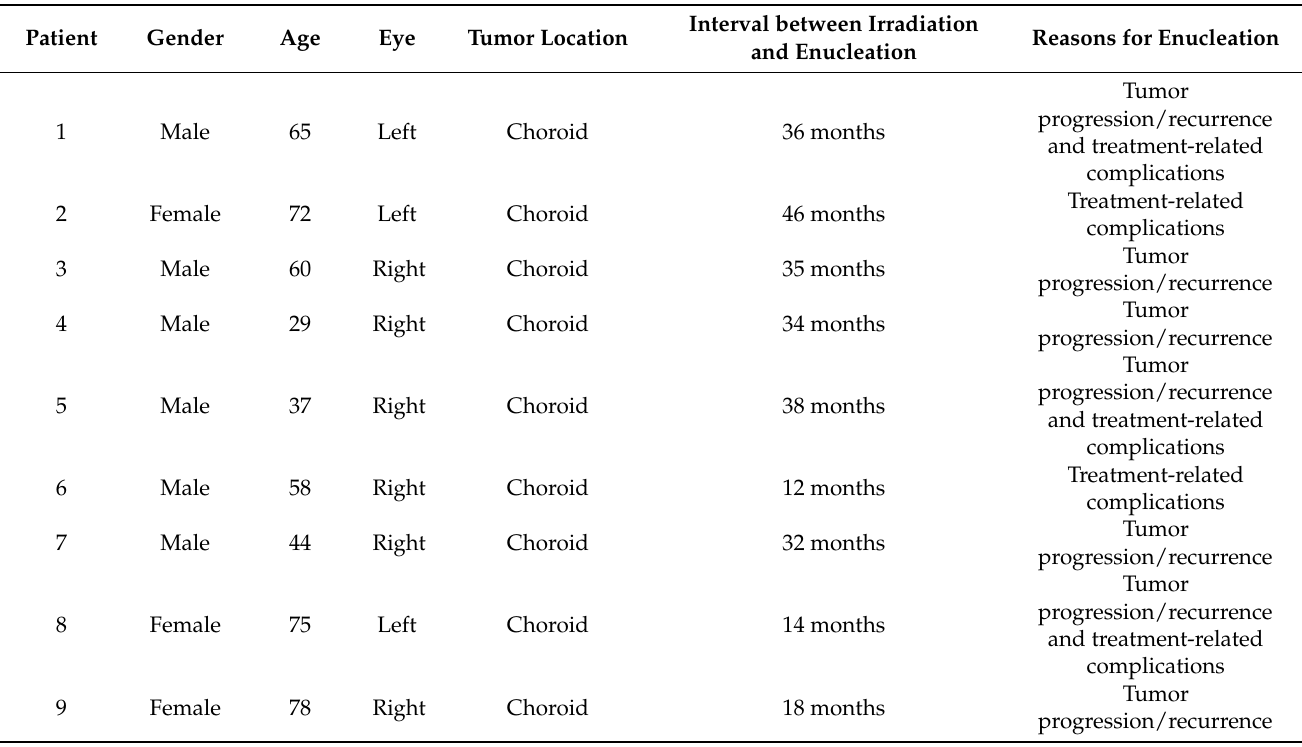
Table 2. Demographic data of the enrolled population.